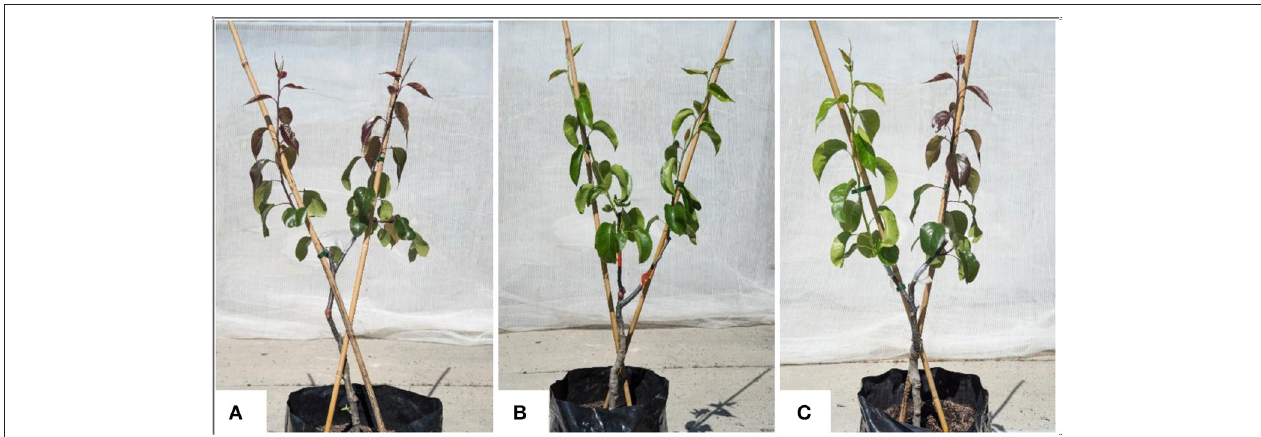
FIGURE 1 | ‘PremP009’ and ‘Hosui’ bi-axis trees grafted with either homogenous or mixed scion genotype (‘PremP009’ or ‘Hosui’) at shoot position (1 or 2). Figure (A) is a homogenous plant of ‘PremP009’ (H P ) with red immature leaves. (B) Represents the homogenous plant of ‘Hosui’ (H H ) with green leaves. (C) Represents a mixed tree (M) with ‘Hosui’ grafted at the lower nodal position (1) and ‘PremP009’ at the higher second nodal position (2). Trees are pictured 42 days after scion